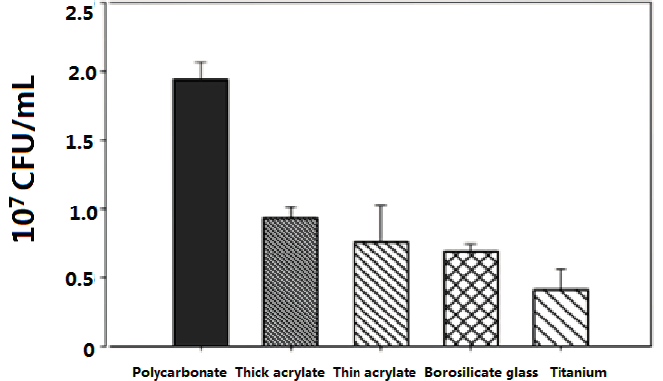
Figure 5. Dynamic tests in flow cells: comparison of Pseudomonas aeruginosa attachment on acrylate (1) surfaces made by spin coating on borosilicate glass coupons (thin = 45 nm polymer thickness, thick = 0.1 mm) with other non coated materials (polycarbonate, bare glass coupon and